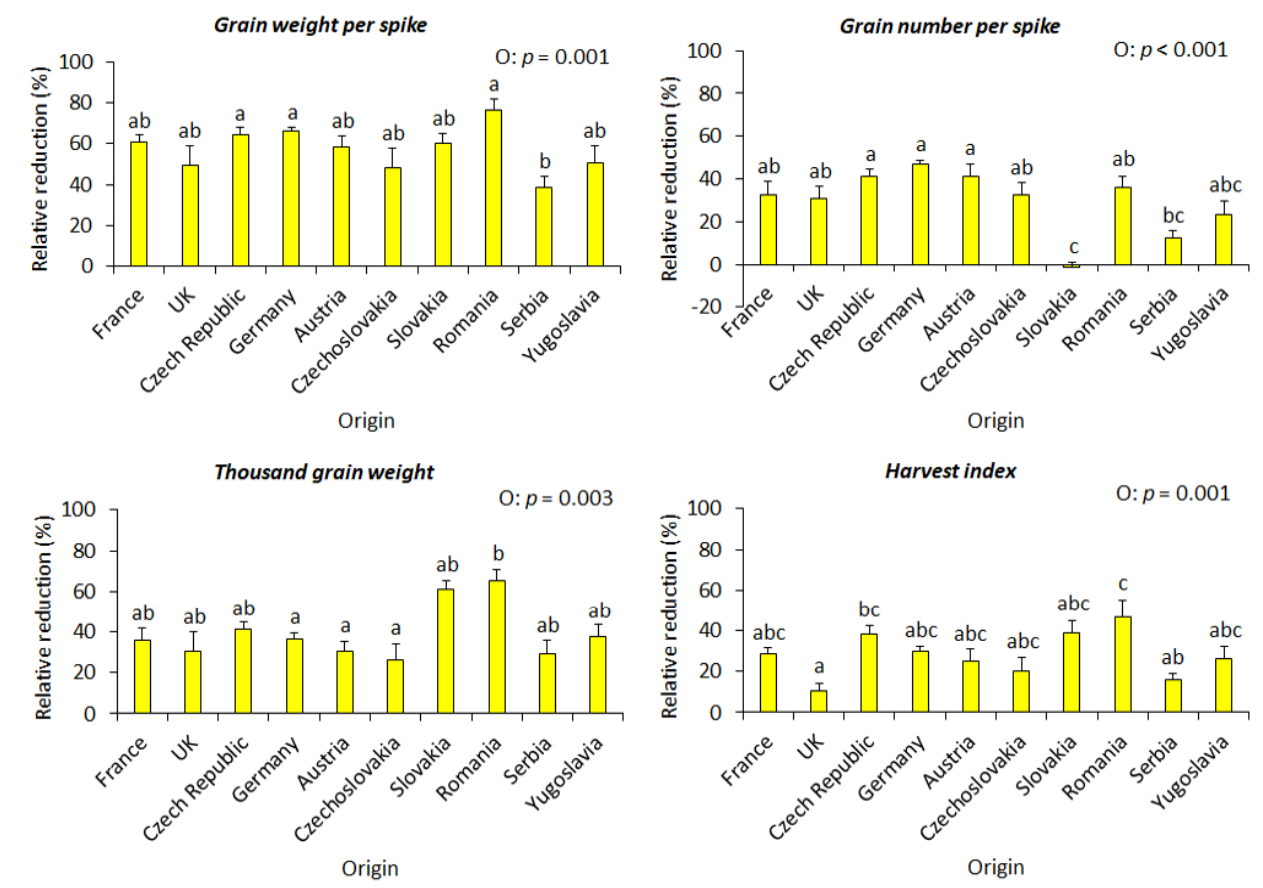
Figure 4. Mean drought-induced relative reductions (%) in specific yield formation parameters for genotypes by country of origin, with the standard errors displayed as error bars. One-way ANOVAs with Tukey’s post hoc tests were performed for all genotypes within each country of origin (O) per yield formation parameter separately ( α = 0.05, n ≥ 5). Different letters above error bars denote statistically significant differences among treatments using Tukey’s post hoc